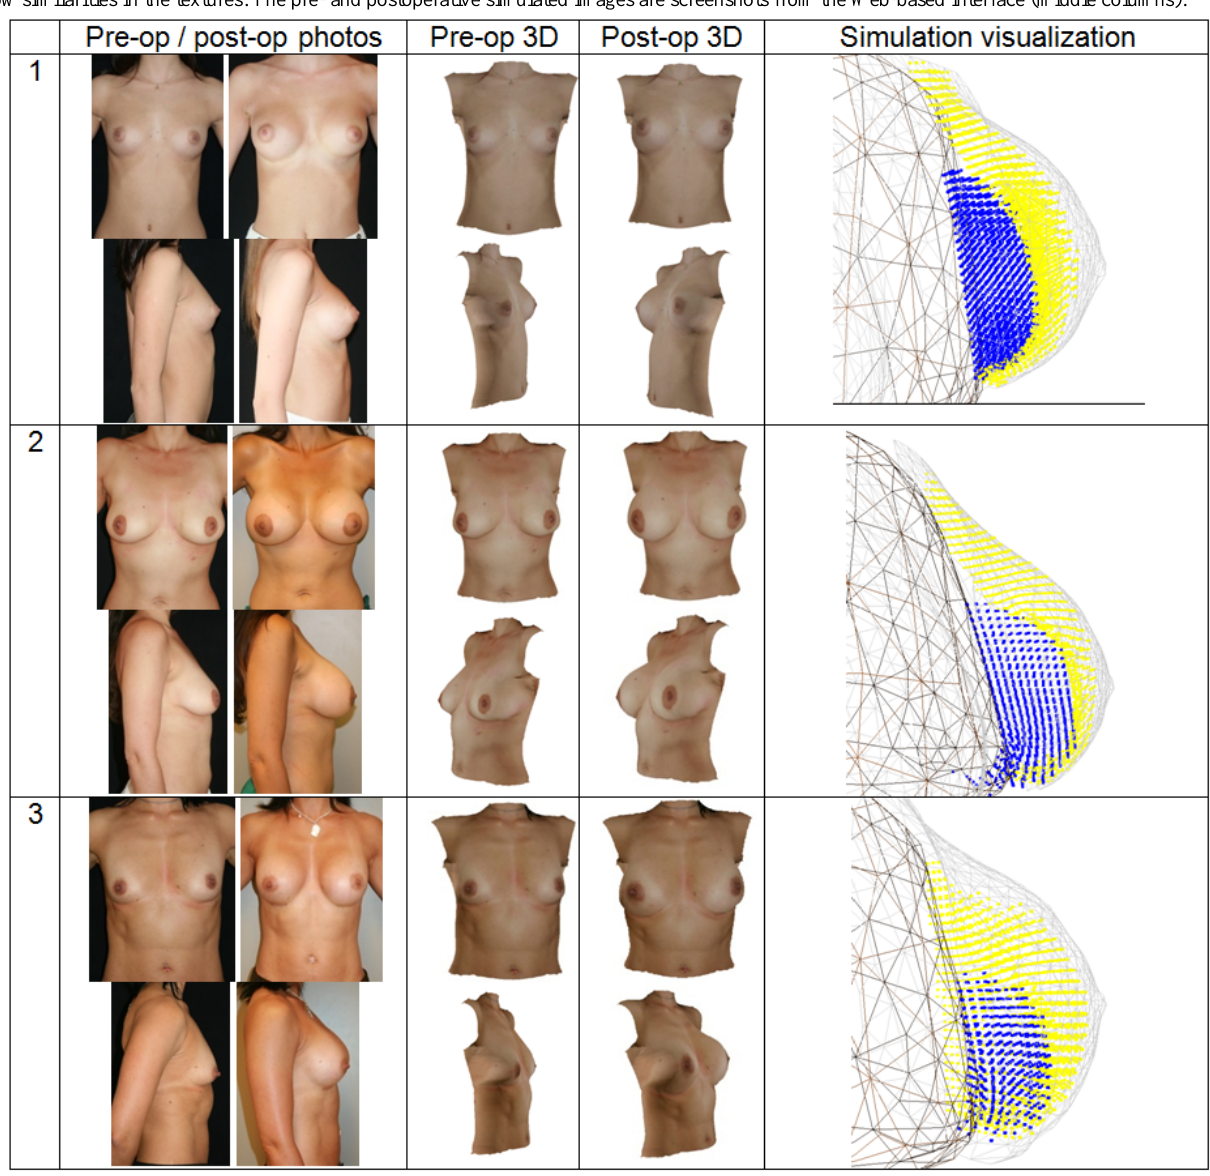
Figure 9. Composite figure showing pre- and postoperative photos, pre- and postoperative 3-dimensional (3D) reconstruction, and implant simulation surface renderings from the simulation visualization. The reconstructed and simulated surfaces were computed from the preoperative photos and hence show similarities in the textures. The pre- and postoperative simulated images are screenshots from the Web-based interface (middle